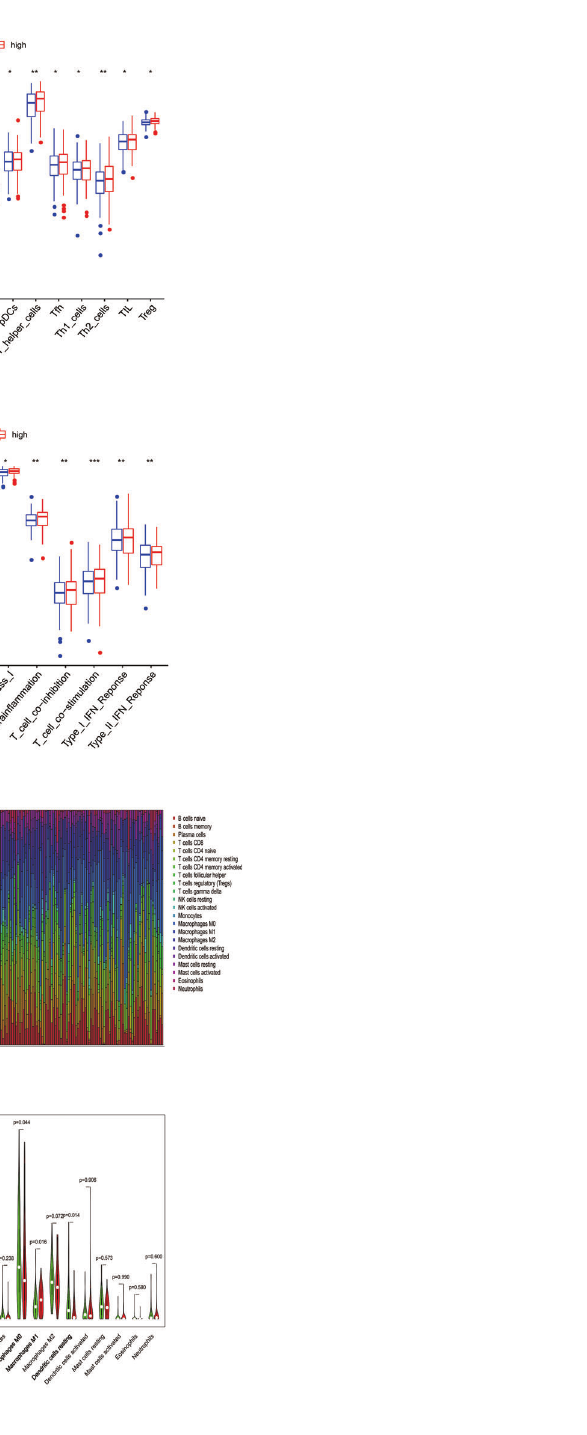
FIGURE 6 | (A) aDCs, B cells, CD8+ T cells, DCs, Macrophages, Mast cells, Neutrophils, NK cells, pDCs, T helper cells, Tfh, Th1 cells, Th2 cells, TIL, and Treg were associated with lower ssGSEA score in the high-risk group (B) APC co-inhibition, APC co-stimulation, CCR, Check − point, Cytolytic activity, HLA, In fl ammation − promoting, MHC class I, Parain fl ammation, T cell co − inhibition, T cell co − stimulation, Type I IFN Reponse, and Type II IFN Response gained lower ssGSEA score in the high-risk group. (C) Taking the median TMB value as a cutoff, the relative expression of 22 tumor-in fi ltrating immune cells in the low- and high-TMB samples was determined. (D) B cells memory, T cells CD8, T cells CD4 memory activated, Tregs, Macrophages M0, Macrophages M1, and Dendritic cells resting showed in fi ltration differences between the low- and high-TMB samples. *P < 0.05, **P < 0.01, ***P < 0.001 and ns, no statistical signi fi